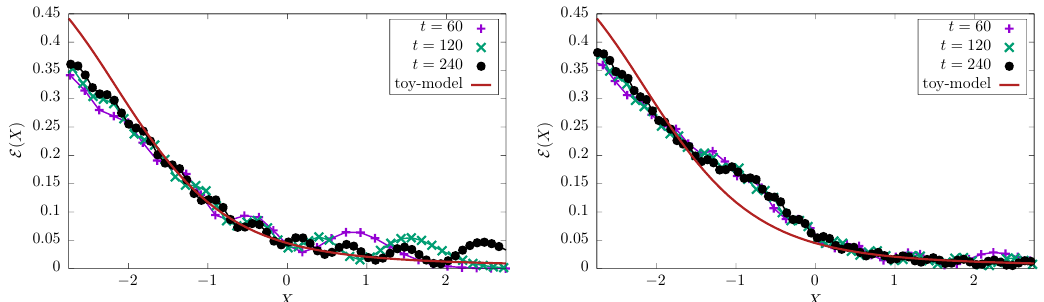
(cid:112) = t 1 − ∆ 2 for increas- e